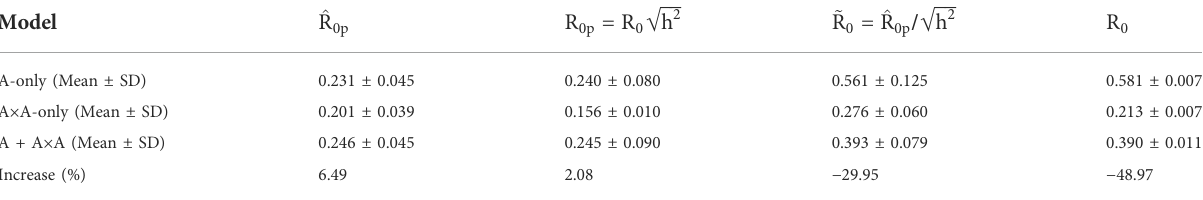
TABLE 4 Comparison of four measures of prediction accuracy in validation populations and differences in the four measures between the two prediction models.